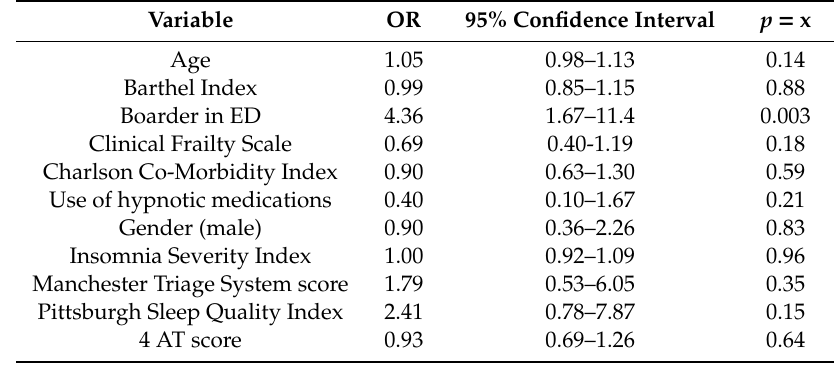
Figure 2. Scatterplot showing the correlation ( r = − 0.1) between baseline clinical insomnia judged by Insomnia Severity Index (ISI) scores and self-reported overnight sleep quality based on Richard Campbell Sleep Questionnaire (RCSQ) scores ( n = 152).